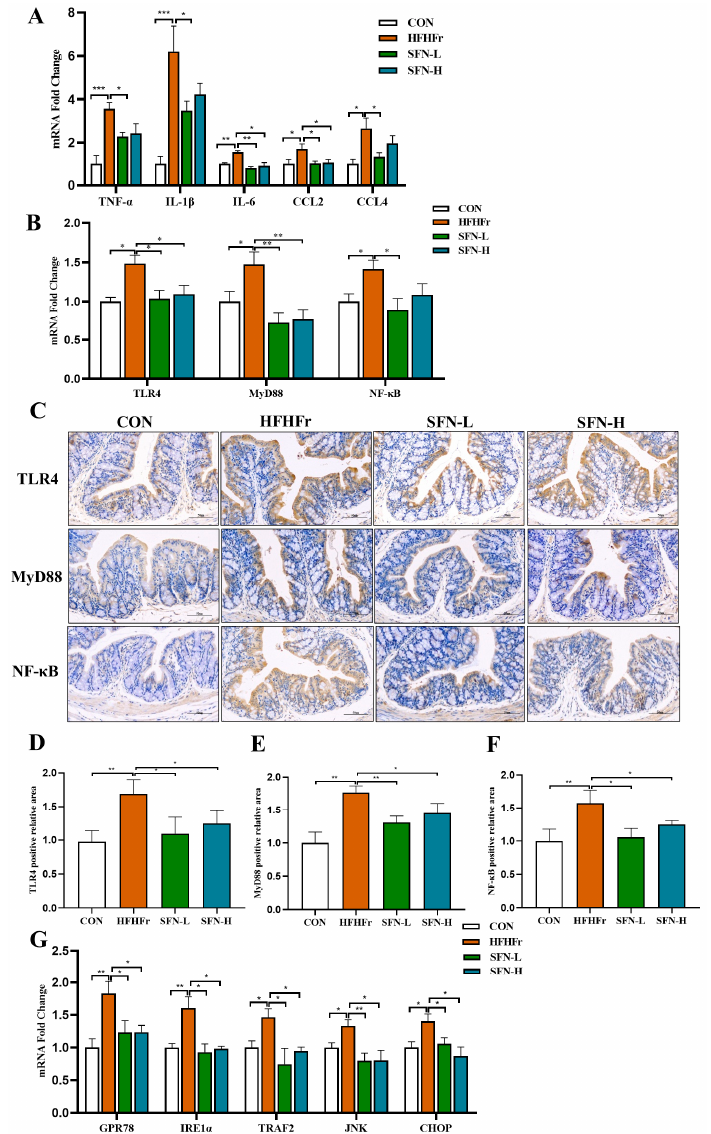
Figure 4. The intervention of SFN alleviates intestinal inflammation in HFHFr mice by inhibiting the TLR4 /NF- κ B pathway and inhibiting endoplasmic reticulum stress. ( A ) The relative mRNA expression of the proinflammatory genes TNF α , IL-1 β , and IL-6 and the chemokines CCL2 and CCL4 in the colon ( n = 6). ( B ) Relative mRNA levels analysis of TLR4, MyD88, and NF- κ B in the colon ( n = 6). ( C ) Representative images of immunohistochemical staining of TLR4, MyD88, and NF- κ B in colon samples ( n = 6). The scale bar is 50 µ m. ( D – F ) Quantification of immunohistochemical staining for TLR4, MyD88, and NF- κ B ( n = 6). ( G ) The relative mRNA expression of endoplasmic reticulum stress-related genes GPR78, IRE1 α , TRAF2, JNK, and CHOP in the colon ( n = 6). Data are shown as mean ± SEM. * p < 0.05, ** p < 0.01, *** p < 0.001 compared with